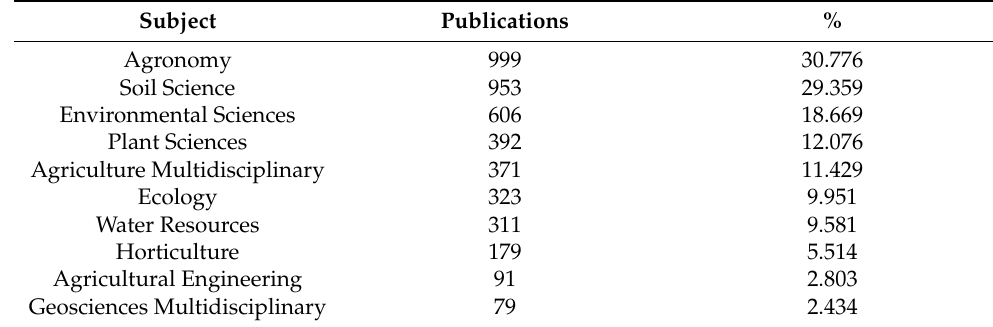
Table 3. Top 10 subject categories with peer-reviewed articles related to CC.